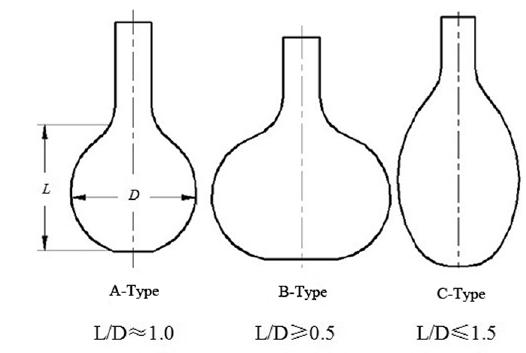
Figure 3: The qualified shapes by electric upsetting.